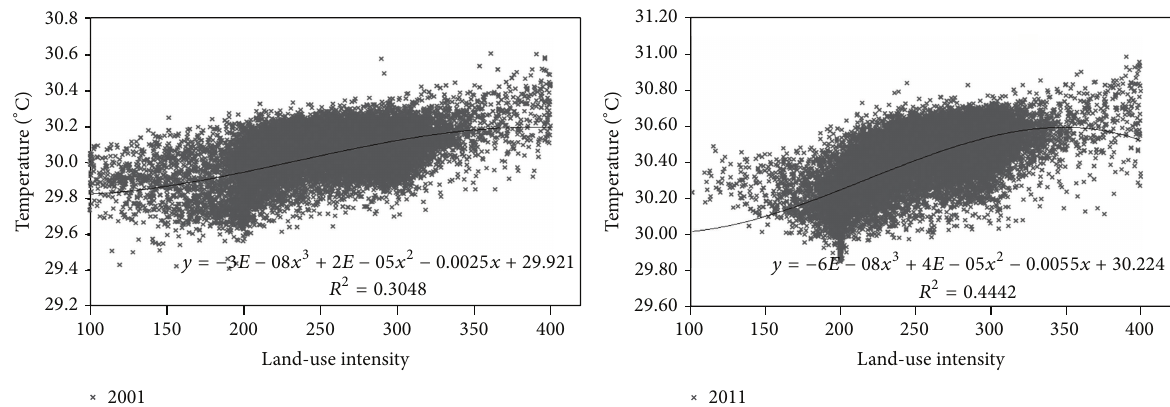
Figure 6: The static relationship of temperature and land-use intensity variations in 2001 and 2011.